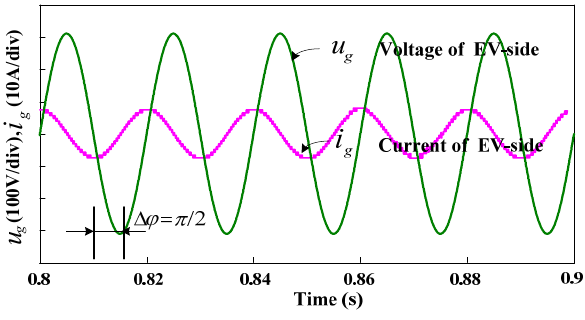
Figure 14. The voltage and current waveforms of the EV-side.